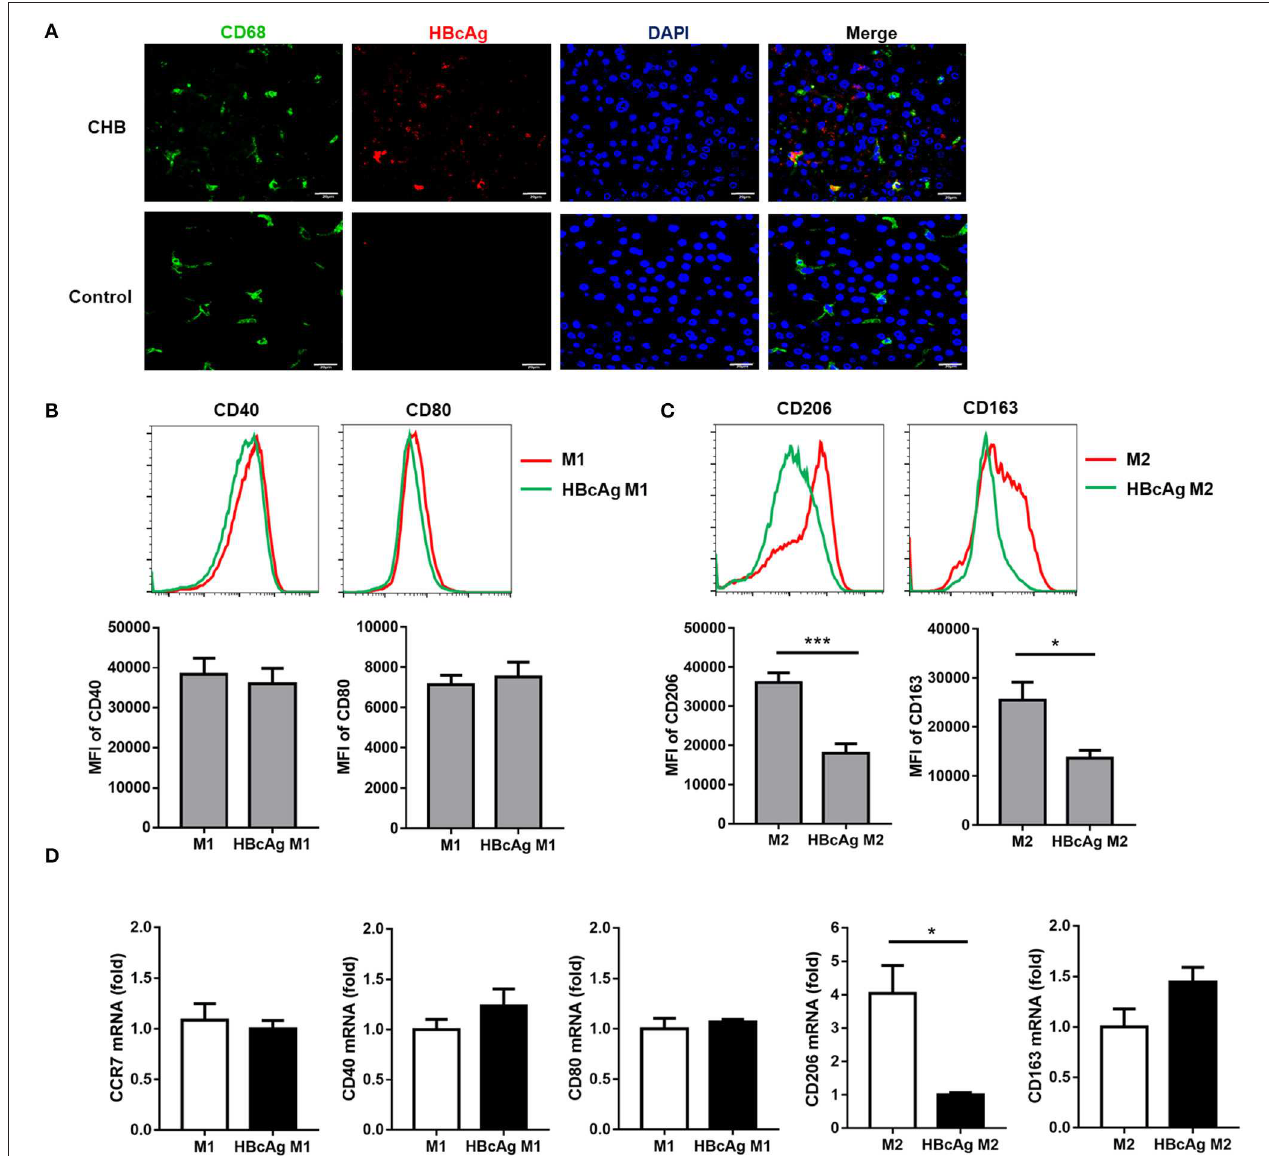
FIGURE 2 | HBcAg selectively inhibited M2 macrophage phenotype. (A) The co-localization between HBcAg and CD68 was detected by immunofluorescence staining. Red and green represent HBcAg and CD68, respectively, blue represents nuclei and yellow represents co-localization. (B–D) 10 µ g/ml HBcAg or an equal volume of PBS was added simultaneously with LPS/IFN- γ or IL-4 to unpolarized M1 or M2 M Φ and incubated for an additional 24h for further polarization. (B) Representative flow cytometric graphs (upper) and cumulative results (lower) showing CD40 and CD80 expression levels in M1 M Φ stimulated with either PBS or HBcAg. (C) Representative flow cytometric graphs (upper) and cumulative results (lower) showing CD206 and CD163 expression levels in M2 M Φ stimulated with either PBS or HBcAg. (D) CCR7, CD40, and CD80 mRNA levels in M1 M Φ or CD206 and CD163 mRNA levels in M2 M Φ stimulated with either PBS or HBcAg were analyzed by RT-qPCR. Experiments in (A–D) were repeated at least two times. Data were analyzed using a paired Student’s t -test. Results are shown as the mean ± SEM ( B–C , n = 8; D , n = 3). * p < 0.05, *** p < 0.001.